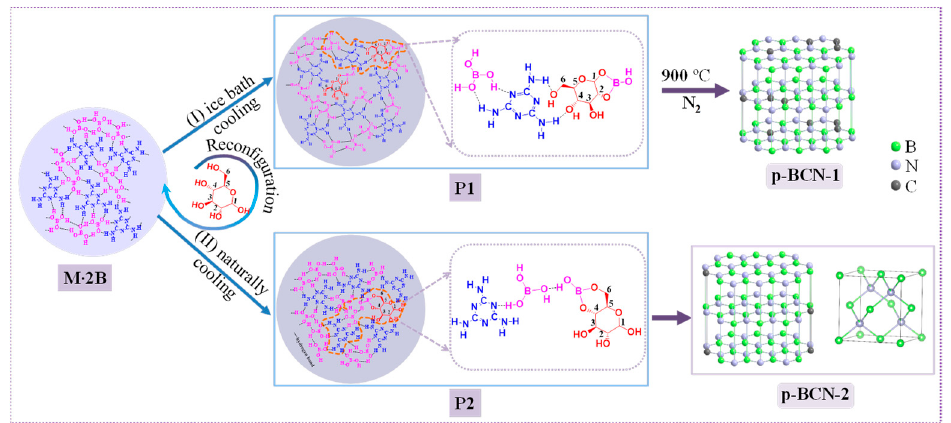
Figure 13. Schematic illustration of p-BCN with different crystal forms prepared by regulating re- crystallization conditions of the homogeneous precursor solution: ( I ) P1-induced h-type p-BCN formation; ( II ) P2-induced h-type and c-type p-BCN formation.